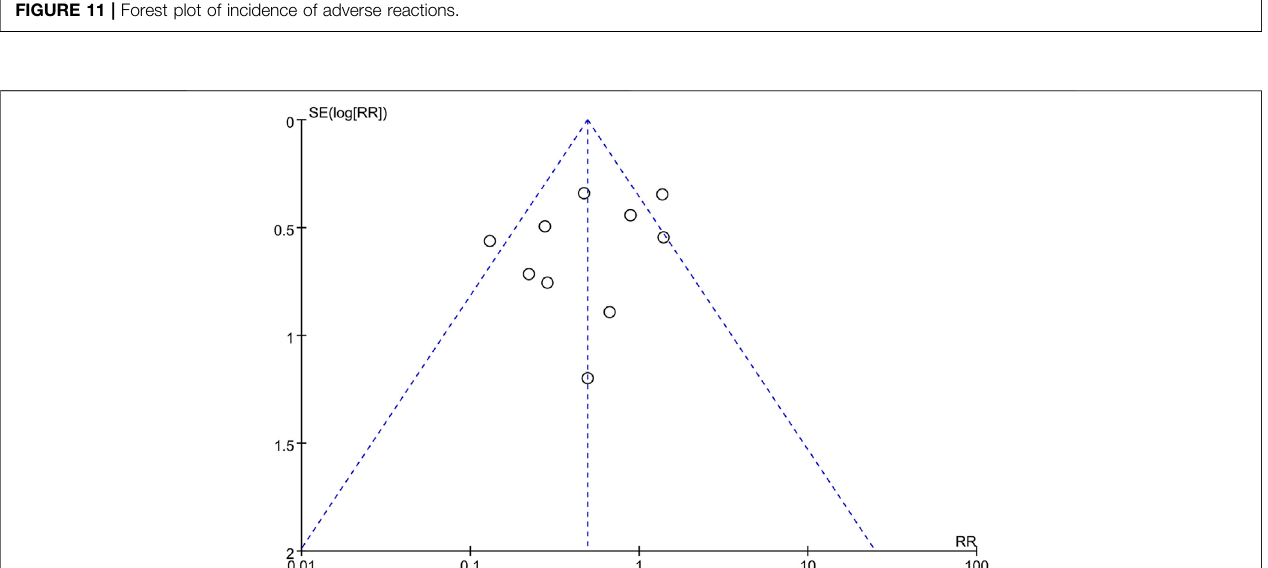
FIGURE 12 | Funnel plot of incidence of adverse